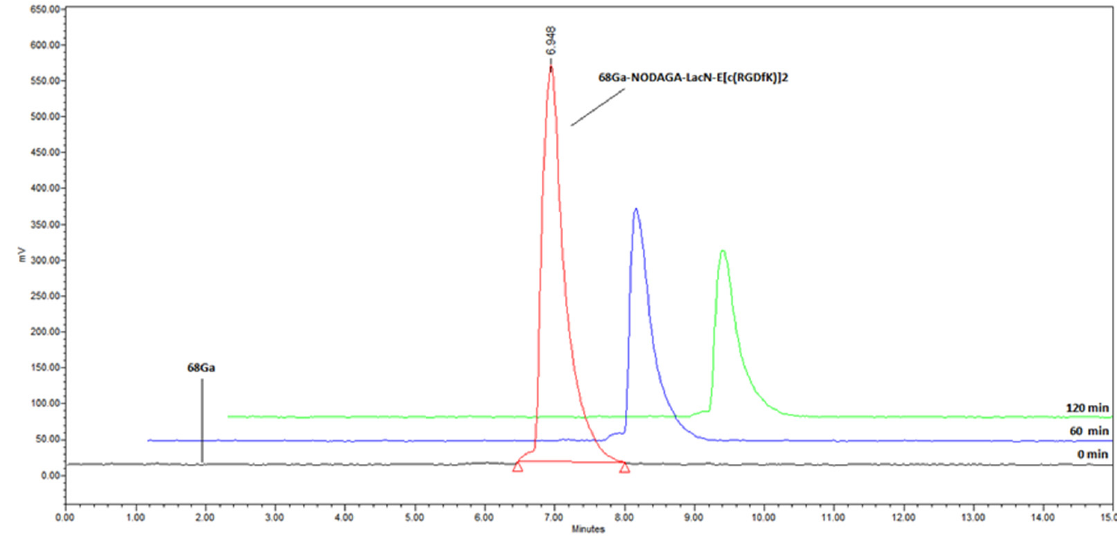
Figure 3. Human serum stability test.